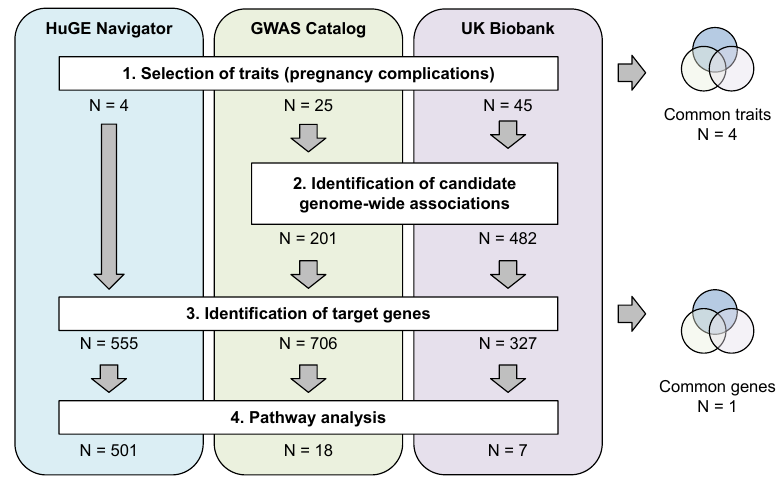
Figure 1. Overview of the data sources and analysis strategy. Numbers indicate the amount of variants, genes, or pathways selected at each